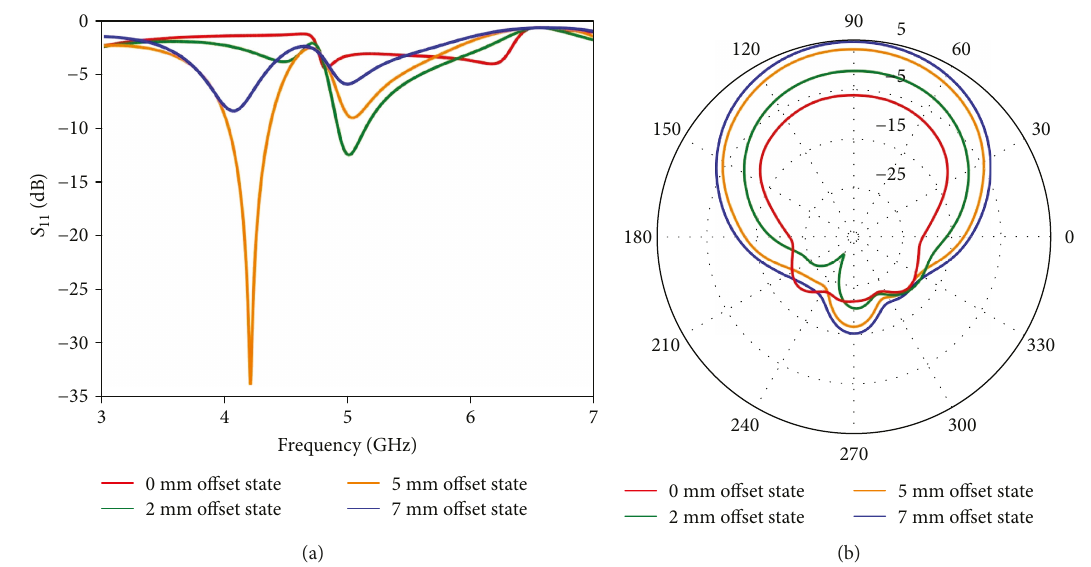
Figure 8: Simulated (a) S and (b) gain of the states corresponding to Figure 11